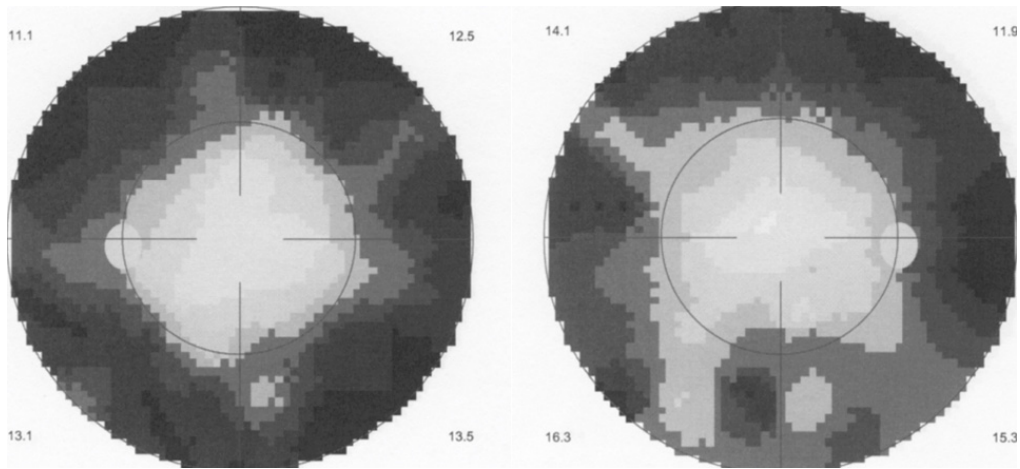
Figure 1. HLA-A29 birdshot retinochoroiditis. Bilateral quasi tubular visual field in a BRC patient still having a visual acuity of 1.0 ODS.